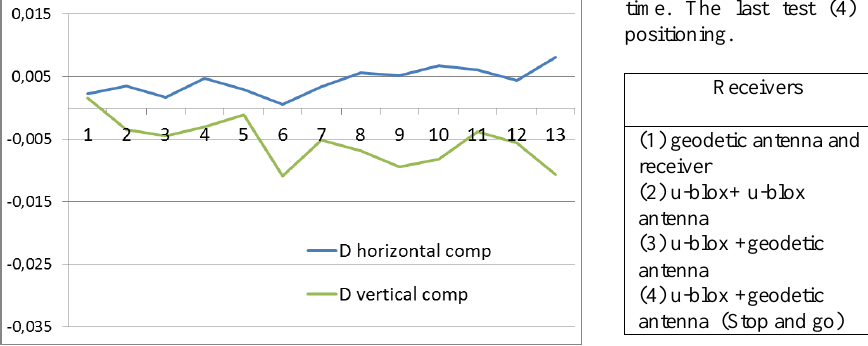
Figure 16. Coordinates differences [m]– mass market receiver and geodetic antenna